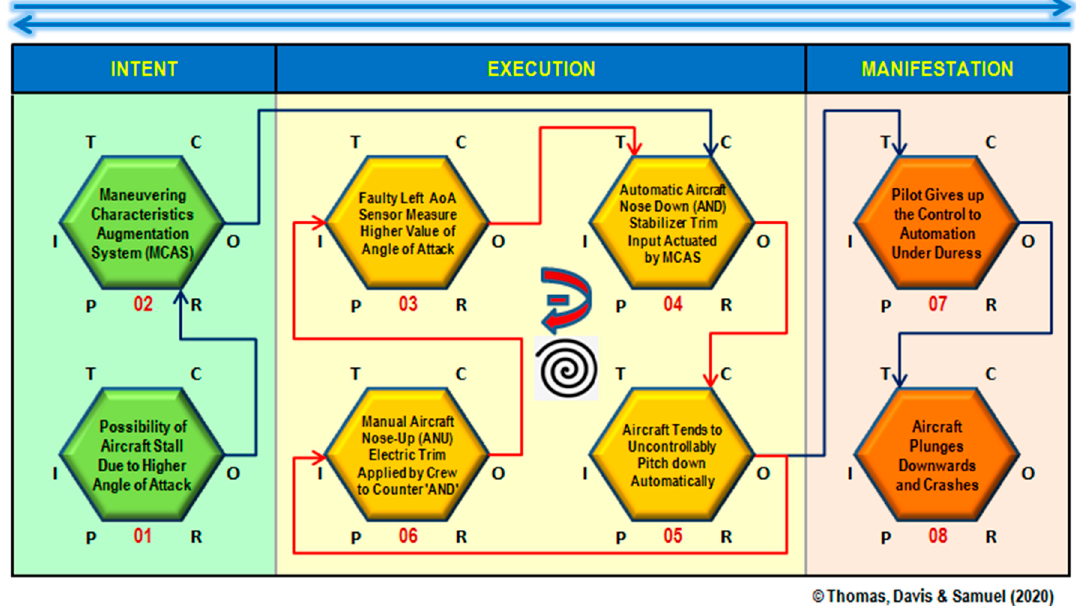
Figure 11. Intent-Execution-Manifestation Continuum—Case Study on Boeing 737 MAX Disasters.